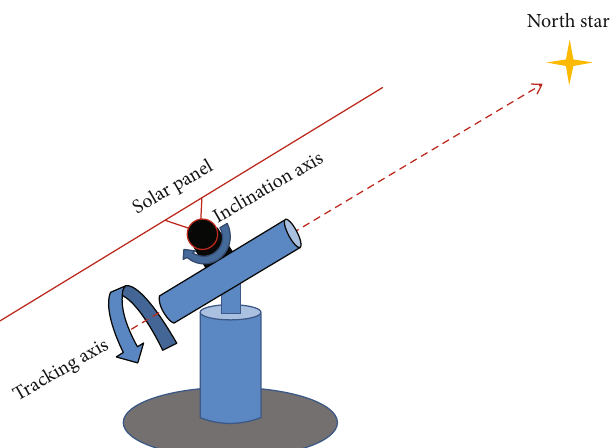
Figure 12: Two-axis solar tracker on an equatorial mount.